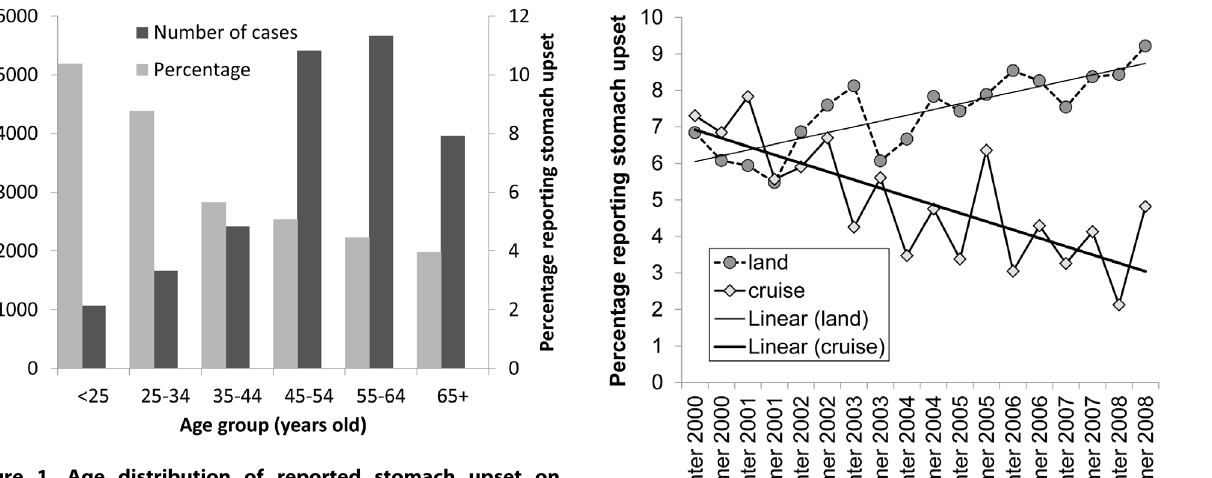
Figure 1. Age distribution of reported stomach upset on cruises.